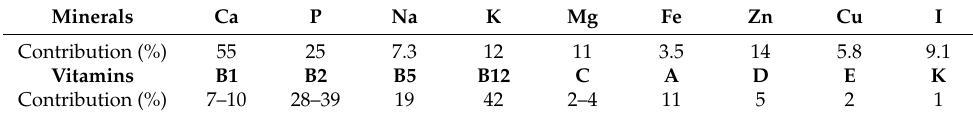
Table 3. Contribution of bovine milk and dairy products to the intake of minerals and vitamins. Data are expressed in %. Adapted from Graulet (2014) [54] and G ó rska-Warsewicz et al. (2019) [55]. Minerals Ca P Na K Mg Contribution